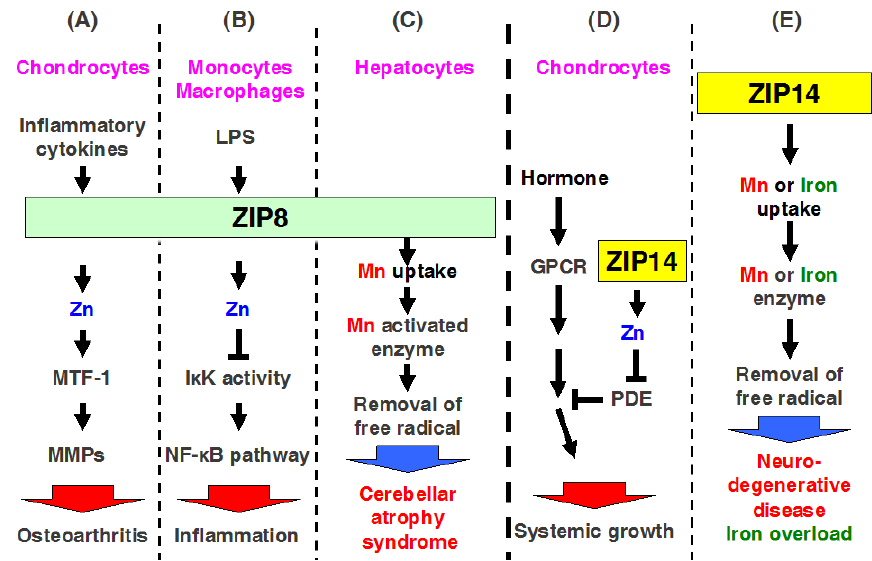
Figure 4. Physiological control by multiple metal transport through ZIP8 and ZIP14. ( A – C ) ZIP8 is involved in inflammatory responses and pathophysiology. ZIP8 expression is induced by ( A ) inflammatory cytokines and endotoxin in chondrocyte and ( B ) monocytes and macrophages, respectively. ( A ) In chondrocytes, ZIP8-mediated Zn activates MTF-1 and increases MMP expression, followed by cartilage degeneration of osteoarthritis; ( B ) In monocytes and macrophages, ZIP8-mediated Zn decreases IKKβ activity and NF - κB signaling and promotes inflammatory responses ; ( C ) Mn (red) is transported by ZIP8. Loss of function of mutated ZIP8 reduces Mn uptake followed by a decrease in Mn-activated enzymes, resulting in cerebellar atrophy syndrome; ( D ) ZIP14 is required for systemic growth and modulates G protein-coupled receptor signaling by inhibiting hormone-stimulated phosphodiesterase (PDE) in chondrocytes; ( E ) Mn (red) and iron (green) are transported by ZIP14. Loss of function of mutated ZIP14 decreases Mn and iron uptake followed by a decrease in either Mn- or iron -activated enzymes, which results in neurodegenerative disease or iron overload disorders.